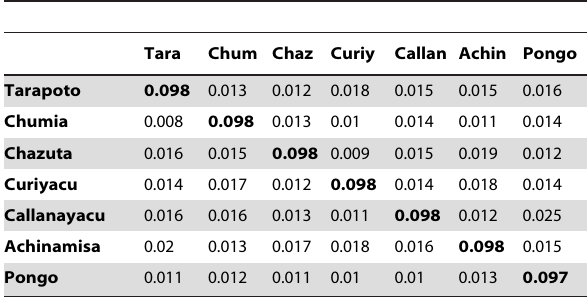
Table 2. Rates of historical gene flow ( m ) derived from the program MIGRATE (Beerli & Felsenstein 1999).